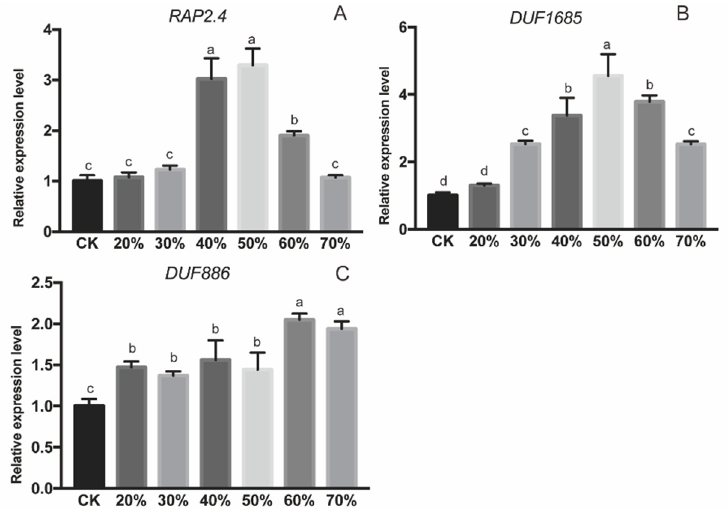
Figure 7. Expression pattern of PtRAP2.4 ( A ), PtDUF1685 ( B ) and PtDUF886 ( C ) under drought stress. Different letters above the columns indicate significant differences at p < 0.05. CK, control samples under well-watered condition.